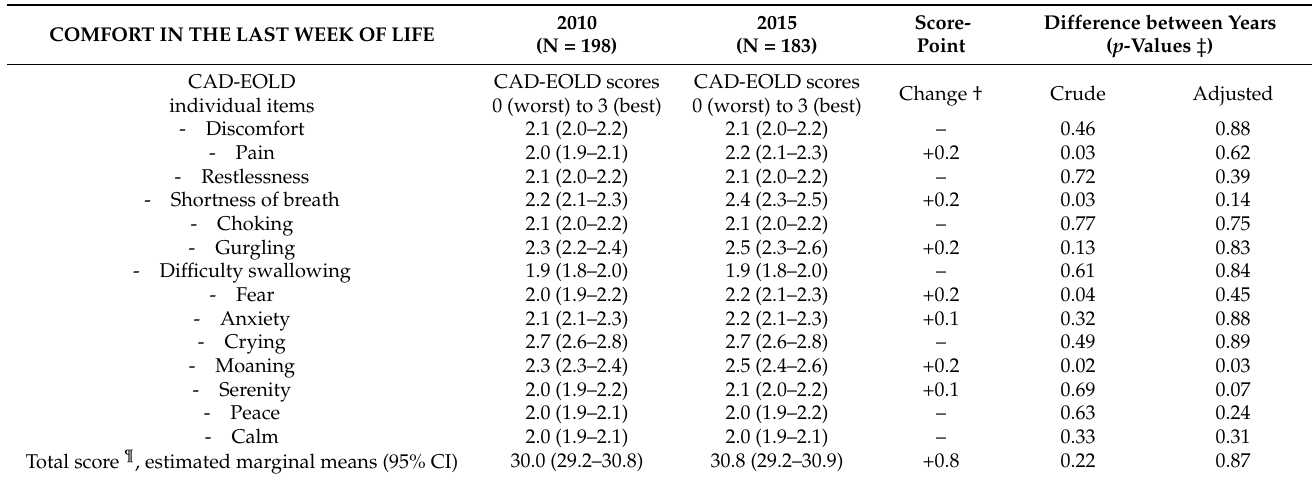
Table 3. Comparing comfort in the last week of life between 2010 and 2015. COMFORT IN THE LAST WEEK OF